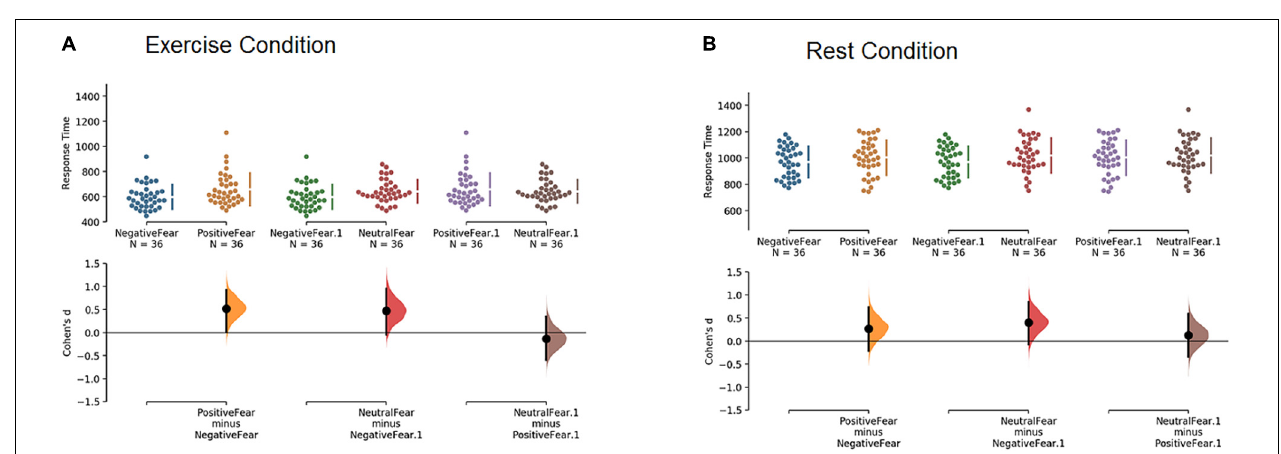
FIGURE 2 | Raincloud plots on correct response time, for Physical Condition, Facial Expression, and Affective Prime.